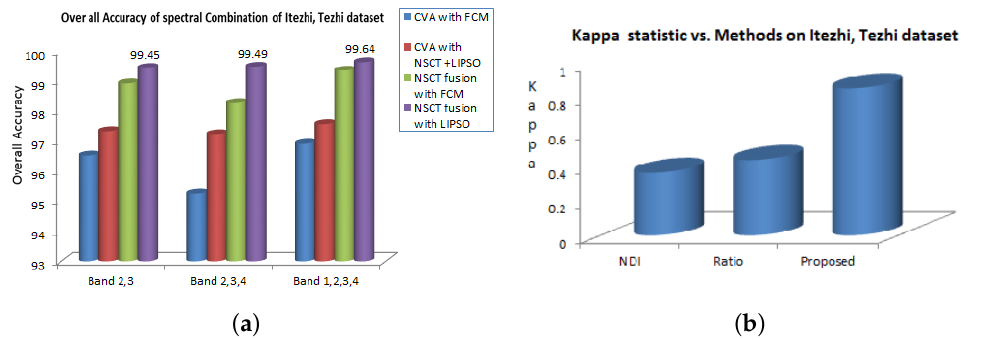
Figure 9. Comparison of accuracy metrics of proposed technique on Itezhi, Tezhi Reservoir, Zambia dataset ( a ) Overall accuracy of various spectral combination methods, and ( b ) Kappa statistic of FCM on normalized difference image (NDI) and Ratio methods against proposed NSCT fusion.